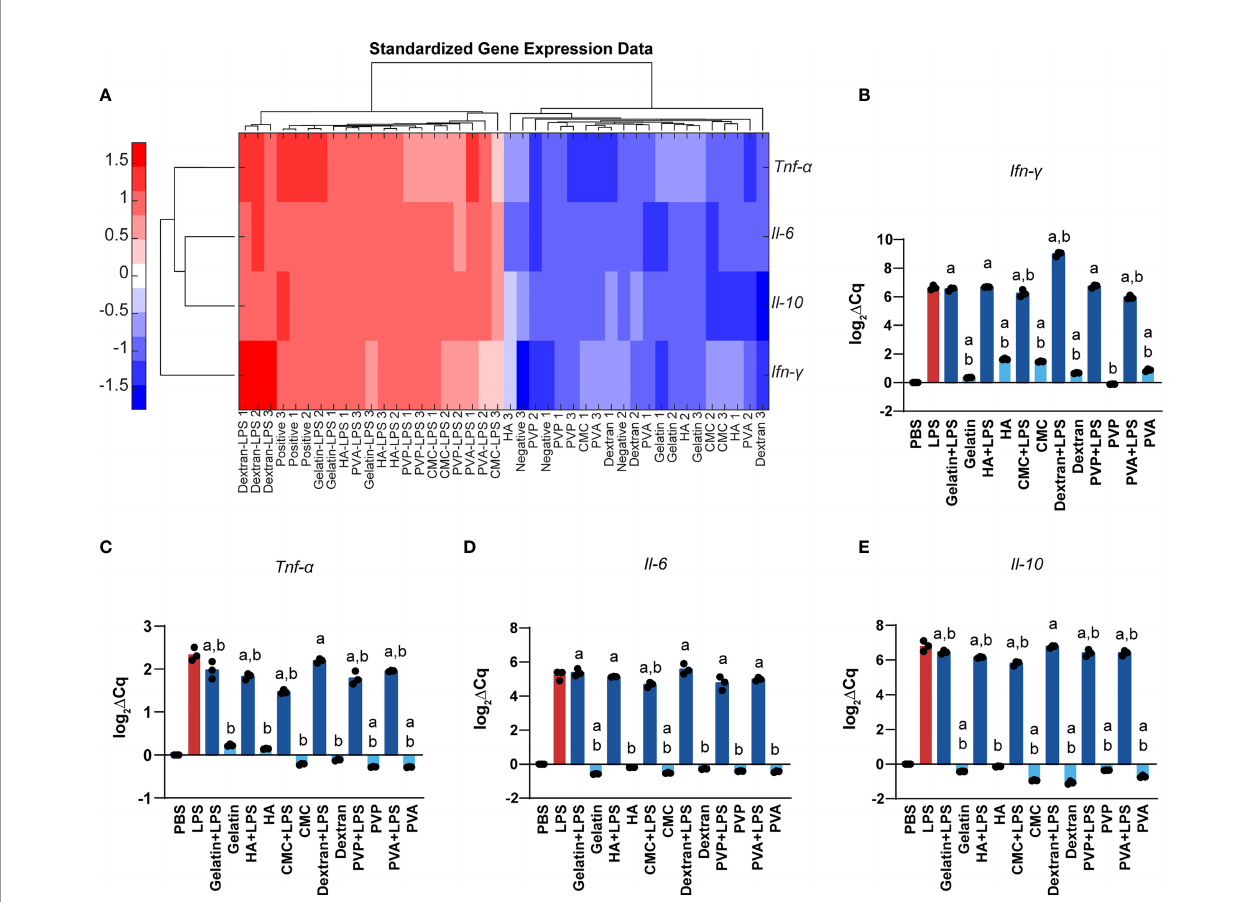
FIGURE 6 | Polymer MNs have signi fi cant but modest differences in gene expression of in fl ammatory as well as regulatory cytokines. (A) Heat map and log2 gene expression data for (B) Ifn- g , (C) Tnf- a , (D) Il-6 , and (E) Il-10 . “ a ” and “ b ” represent signi fi cant statistical differences (p < 0.05) when compared with PBS and LPS group